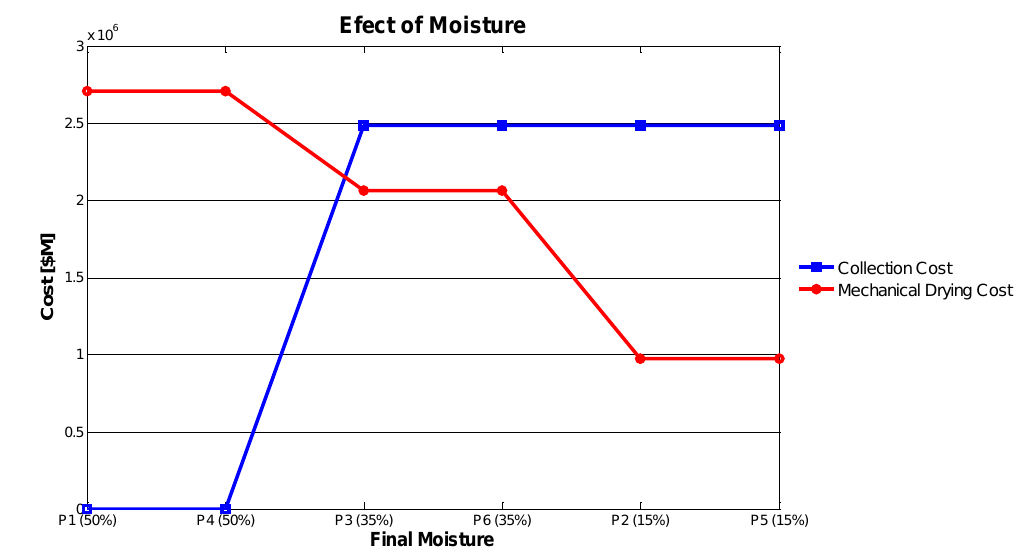
Figure 6. Comparison between the collection and mechanical drying costs.